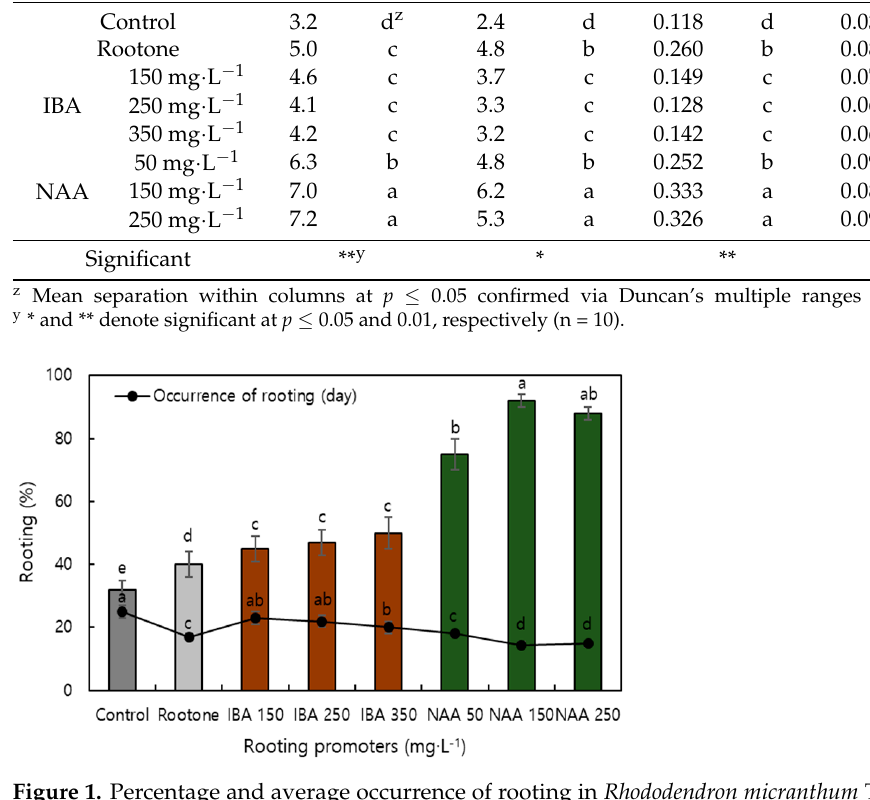
Table 2. Characteristics of root growth as affected by rooting promoters at 70 days after cutting Rhododendron micranthum Turcz. Rooting Promoters